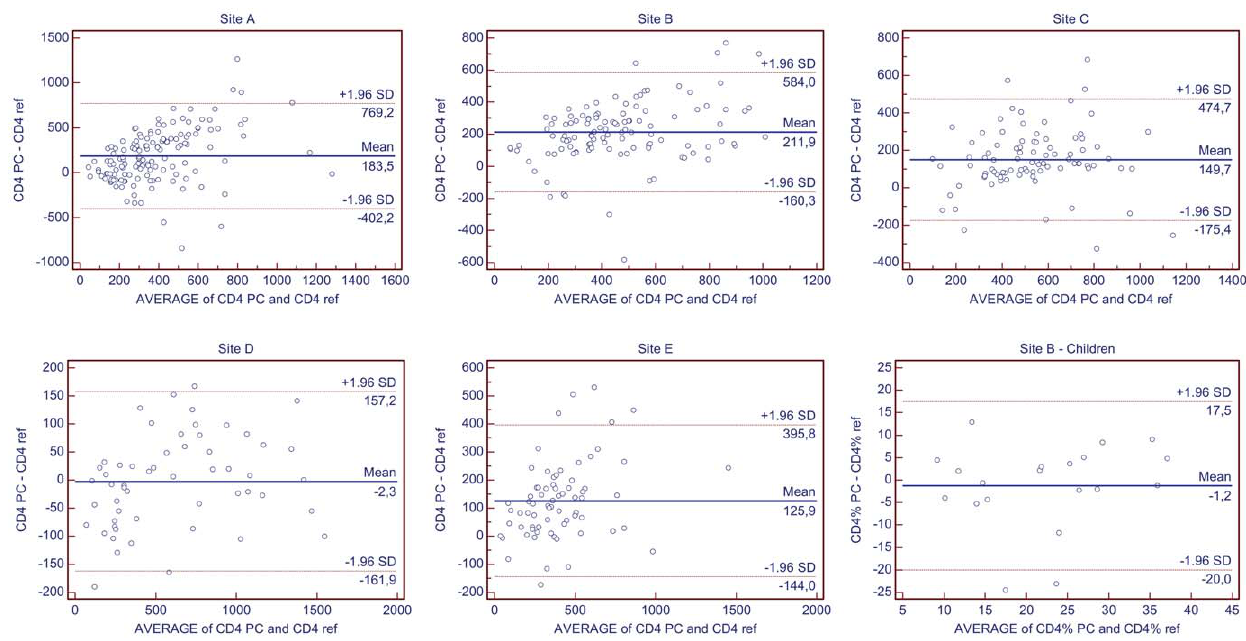
Figure 1. Bland-Altman graphs for CD4 agreement of each site evaluation. Bias was plotted per site (A–E, and for children in site B) on all data range. Horizontal lines report mean bias (Mean) and limits of agreement (1.96 SD). Absolute CD4 count (CD4, in cells/ m l), or relative CD4 (CD4%, in %) on PointCare NOW (PC) or on reference instrument (ref).